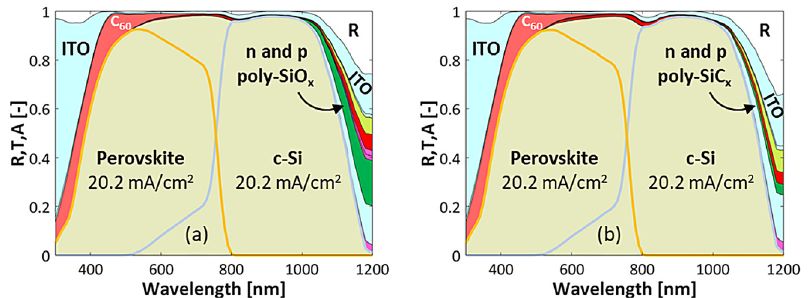
Figure 2: Reflectance and absorptance of 2T perovskite/c-Si tandem solar cell (see Figure 1(a)) with top cell as in the study by Sahli et al. [8] and bottom cell as (a) poly-SiO x passivated c-Si solar cell or (b) poly-SiC x passivated c-Si solar